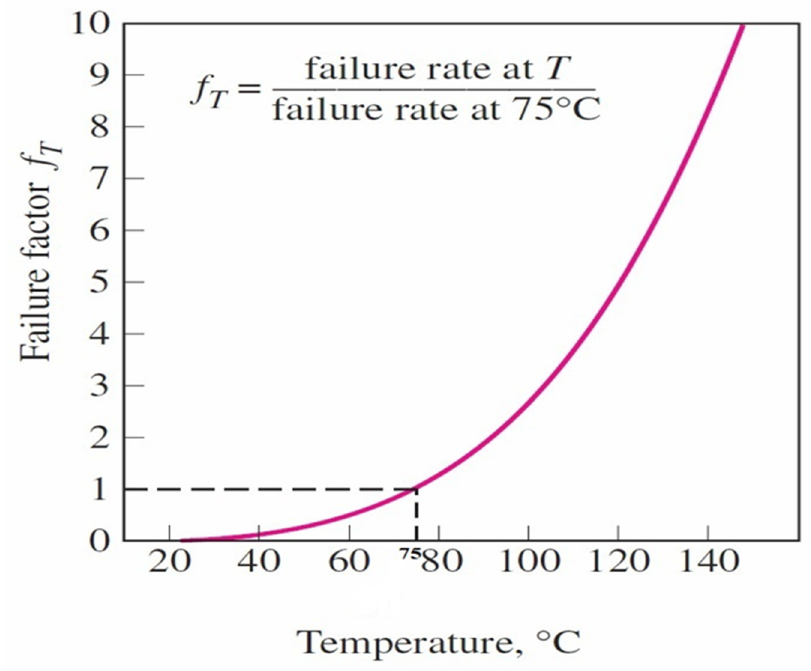
Figure 1. Graph of failure factor vs. temperature of a device [6].